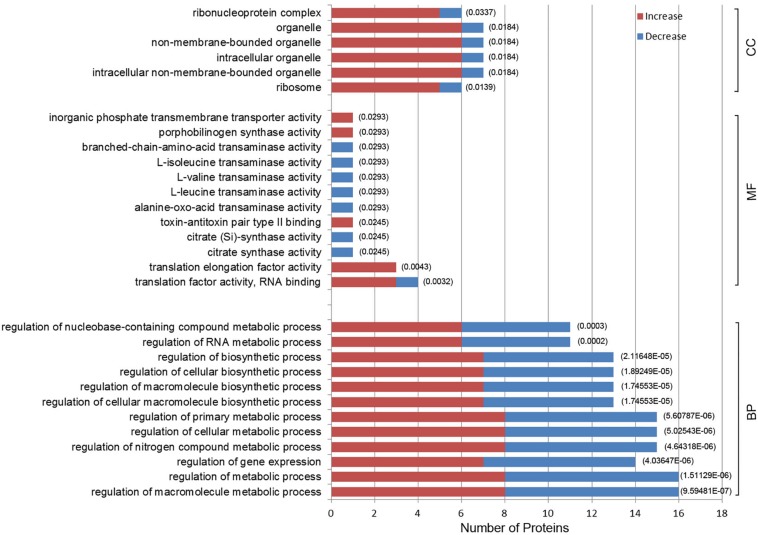
Gene Ontology (GO) enrichment analysis of 96 differentially expressed proteins in N. gonorrhoeae isolates. The histogram shows the top-10 most enriched categories. The P-values are marked at the top of the bars. Complete list of the enriched proteins are provided in Supplementary Data Sheet S2. BP, biological process; MF, molecule function; CC, cellular component.